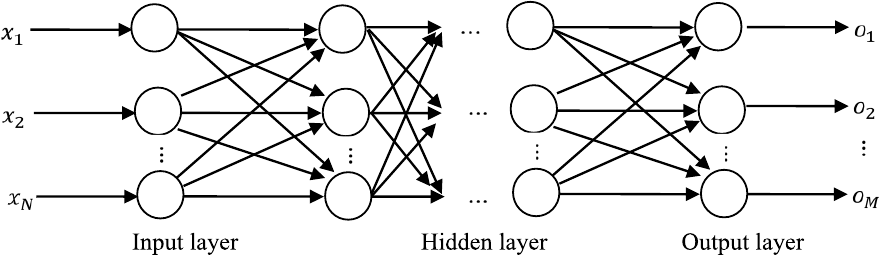
Figure 5. Multi-layer perceptron for neural network architecture.